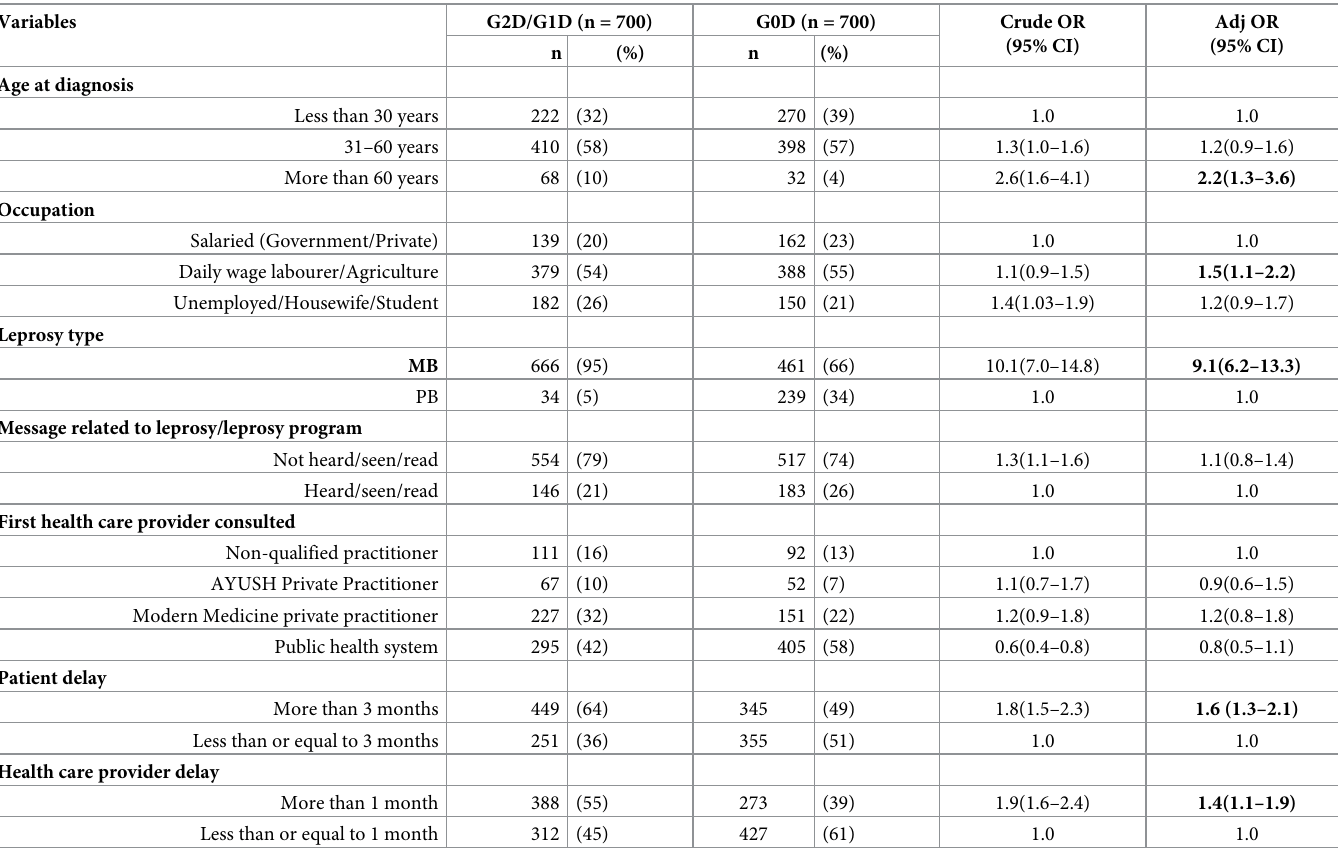
Table 3. Risk factors for G2D/G1D among adult leprosy cases in 5 states of India,